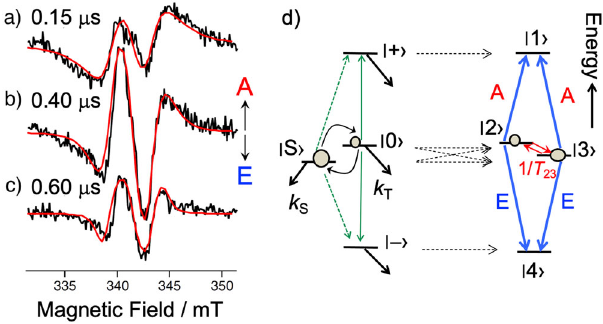
Fig. 2 Time-resolved EPR (TREPR) of the spin-correlated radical pair. a – c Delay time ( t d ) dependence of the TREPR spectrum obtained by the depolarized 450 nm laser irradiation of WT XlCry -DASH at 120 K, showing E/A/E/A patterns. d The spin correlated radical pair (SCRP) levels